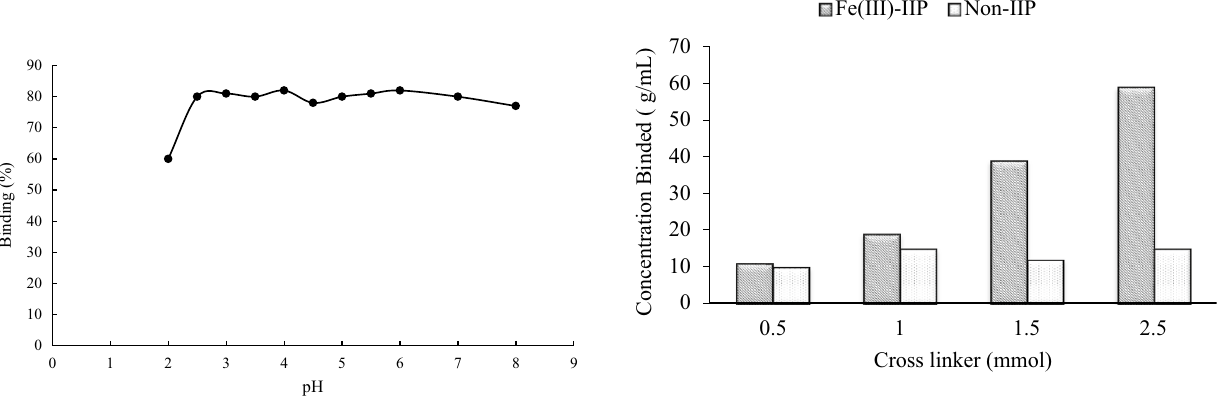
Fig. 2 Effect of pH on the retention of Fe(III) by Fe(III)-IIP